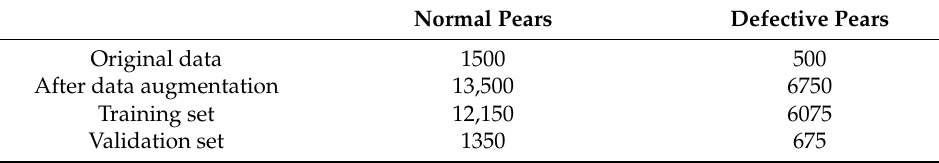
Table 1. Dataset details